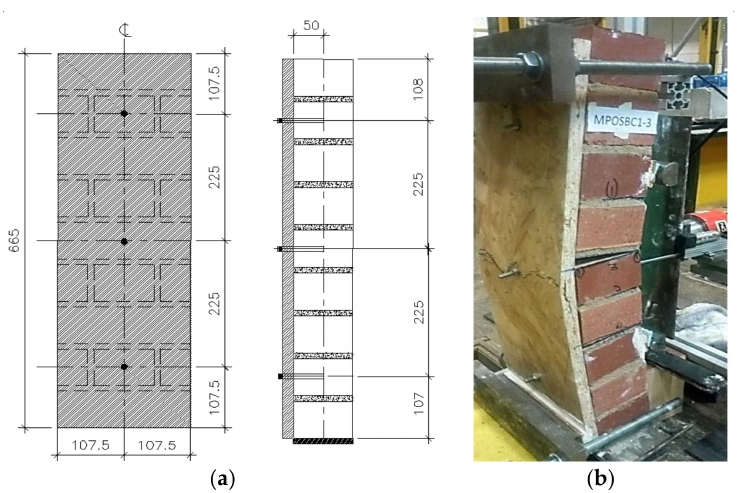
Figure 7. MP specimen: ( a ) geometry and ( b ) failure pattern (MP00-3 as an example).